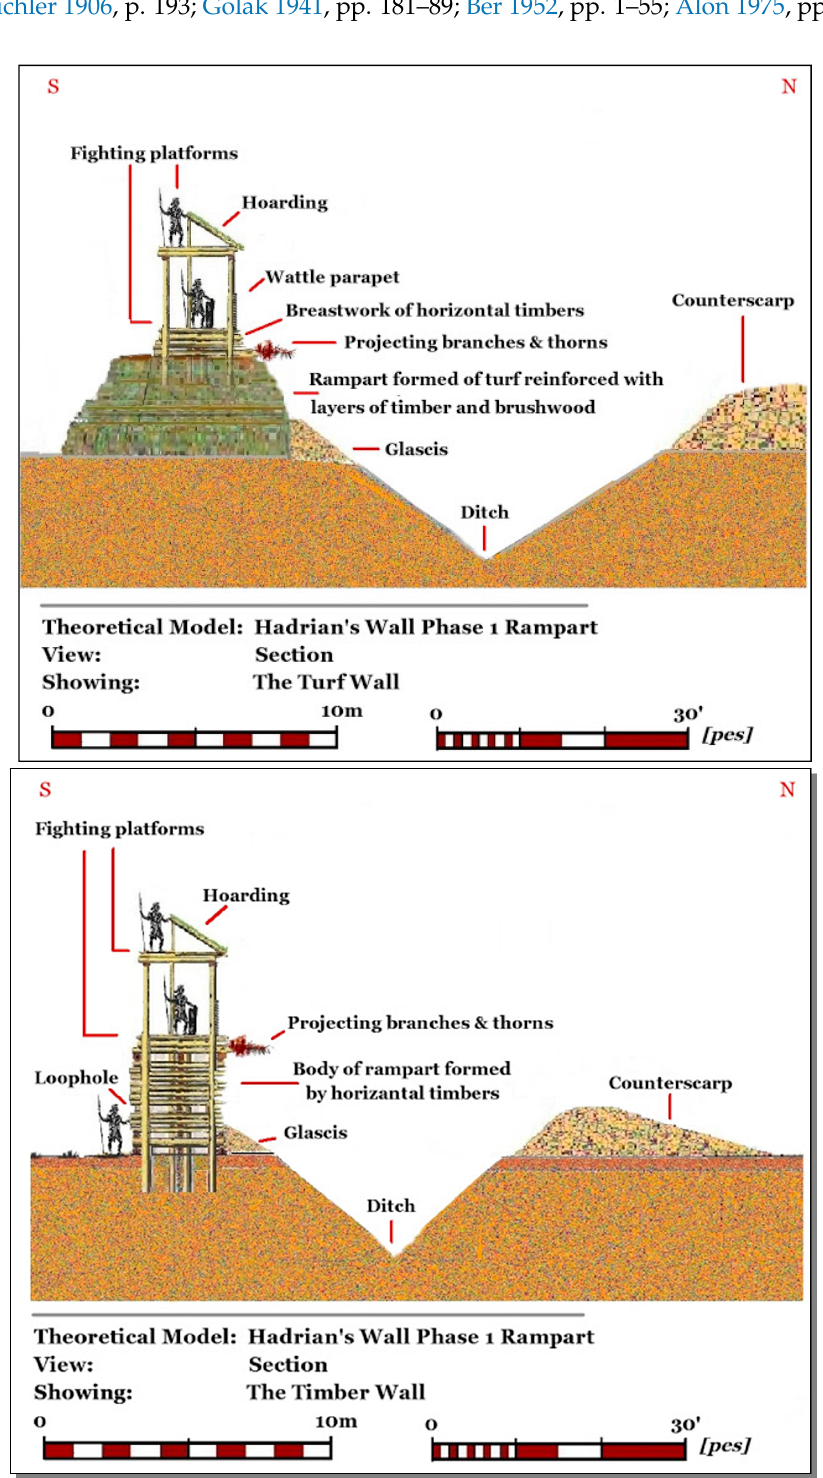
Figure 5. Reconstruction of two types of rampart (turf rampart and timer rampart), in Hadrian’s Wall (Vallum Aelium). Source:http://structuralarchaeology.blogspot.co.il/2011/12/hadrians-first-wall.html. (by permission of Geoff Carter. See: http://structuralarchaeology.blogspot.com/)